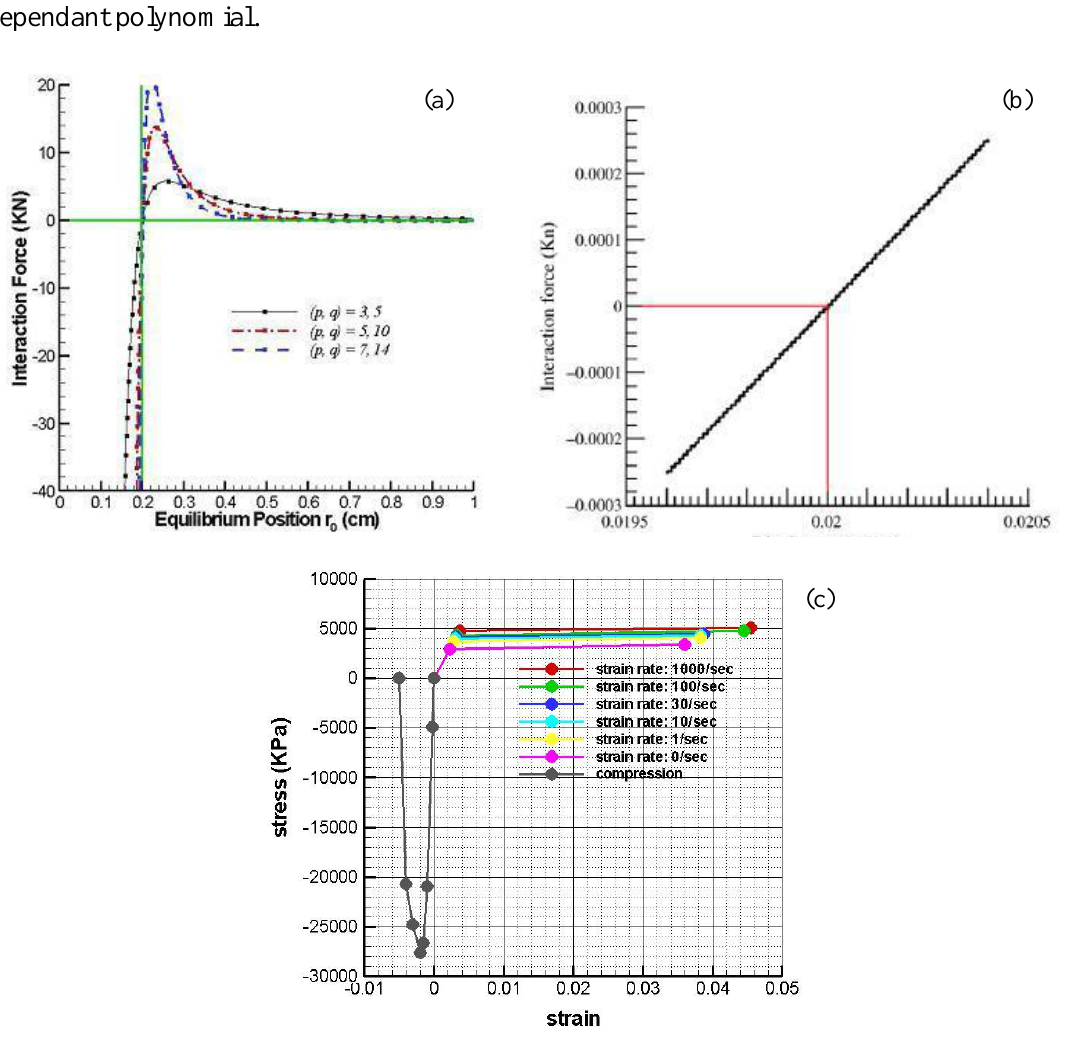
Figure 2. Force interaction types of HLPM: (a) Lennard–Jones, (b) linear, (c) strain-rate dependant